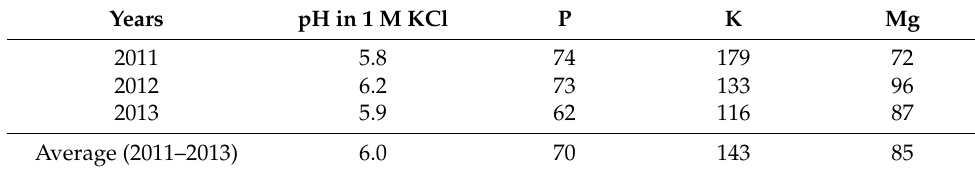
Table 1. Soil pH and abundance in macronutrients (mg kg − 1 ).